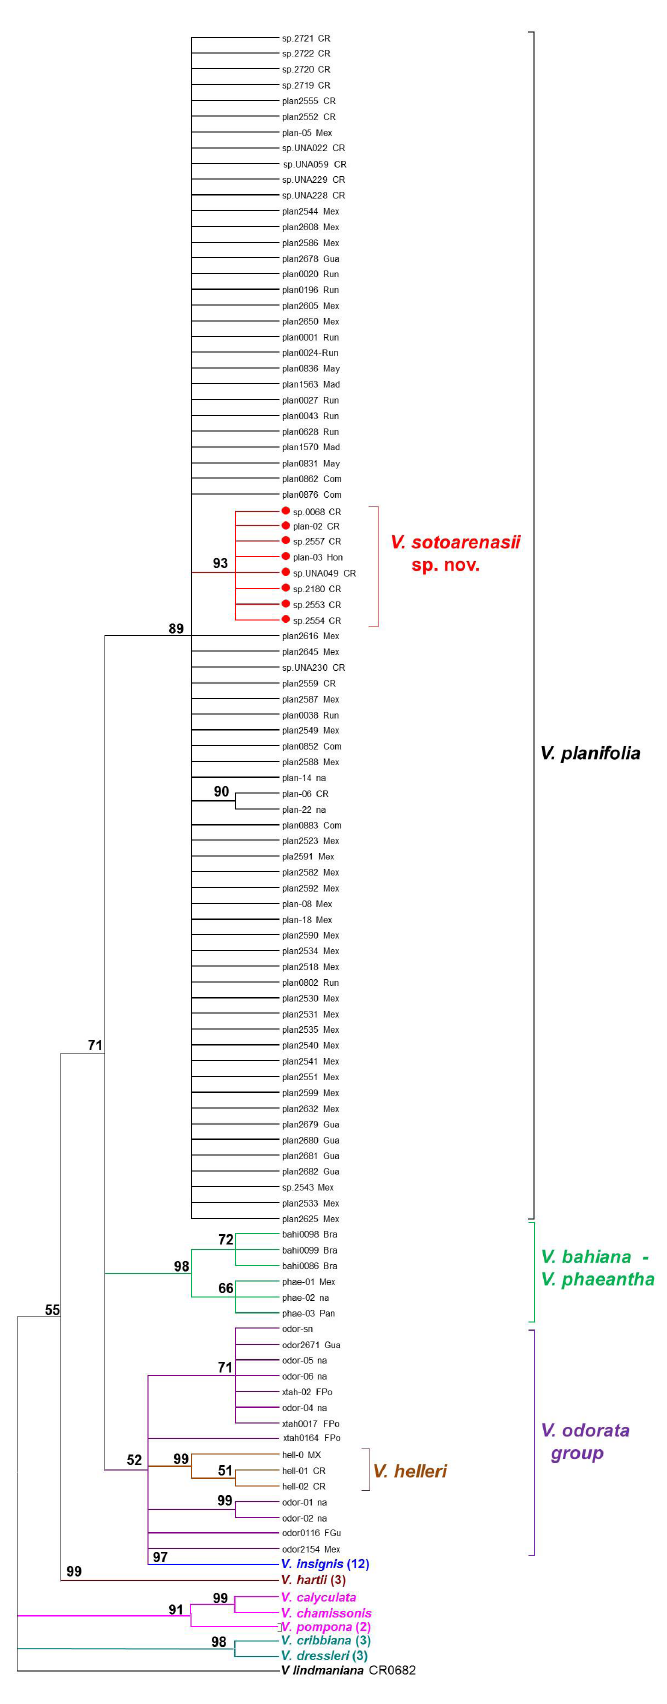
Fig. 4. Phylogenetic tree derived from the partial ITS sequences (506 positions) of the 125 accessions listed in Table 1, showing the differentiation of the Vanilla sotoarenasii M.Pignal, Azofeifa-Bolaños & Grisoni sp. nov. clade from V. planifolia Jacks. ex Andrews and all other related species. The tree was inferred using the Maximum Likelihood method based on the Tamura-Nei model with invariant sites and Gamma distribution of evolutionary rates. The figures indicate the percentage of bootstrap support. Branches with less than 65% support were collapsed. Countries of origin: Bra = Brazil; Com = Comoros: CR = Costa Rica; FGu = French Guiana; FPo = French Polynesia; Gua = Guatemala; Hon = Honduras; Mad = Madagascar; May = Mayotte; Mex = Mexico; Run = La Réunion; na = geographic origin not available. Numbers in brackets indicate the number of similar accessions merged in one branch for outgroup